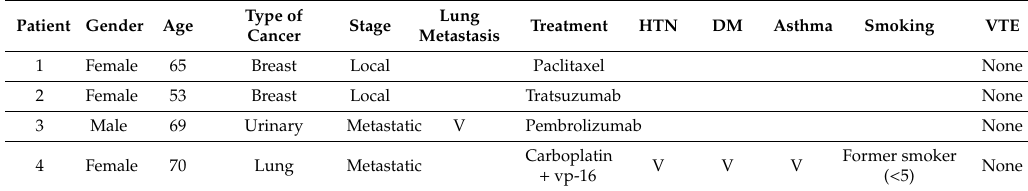
Table 2. Description of COVID19 serology-positive